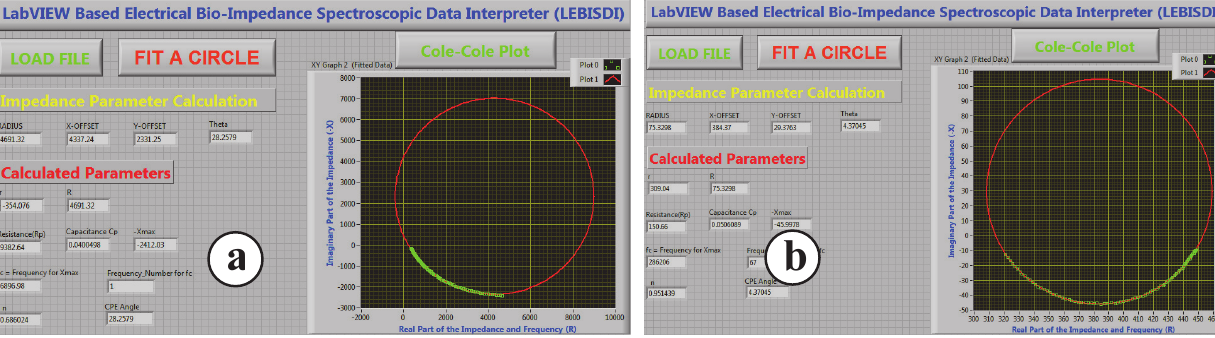
Fig.18: Analysis of the variation in the impedance data obtained from the impedance parameter in LEBISDI for a green banana (a) before and (b) after